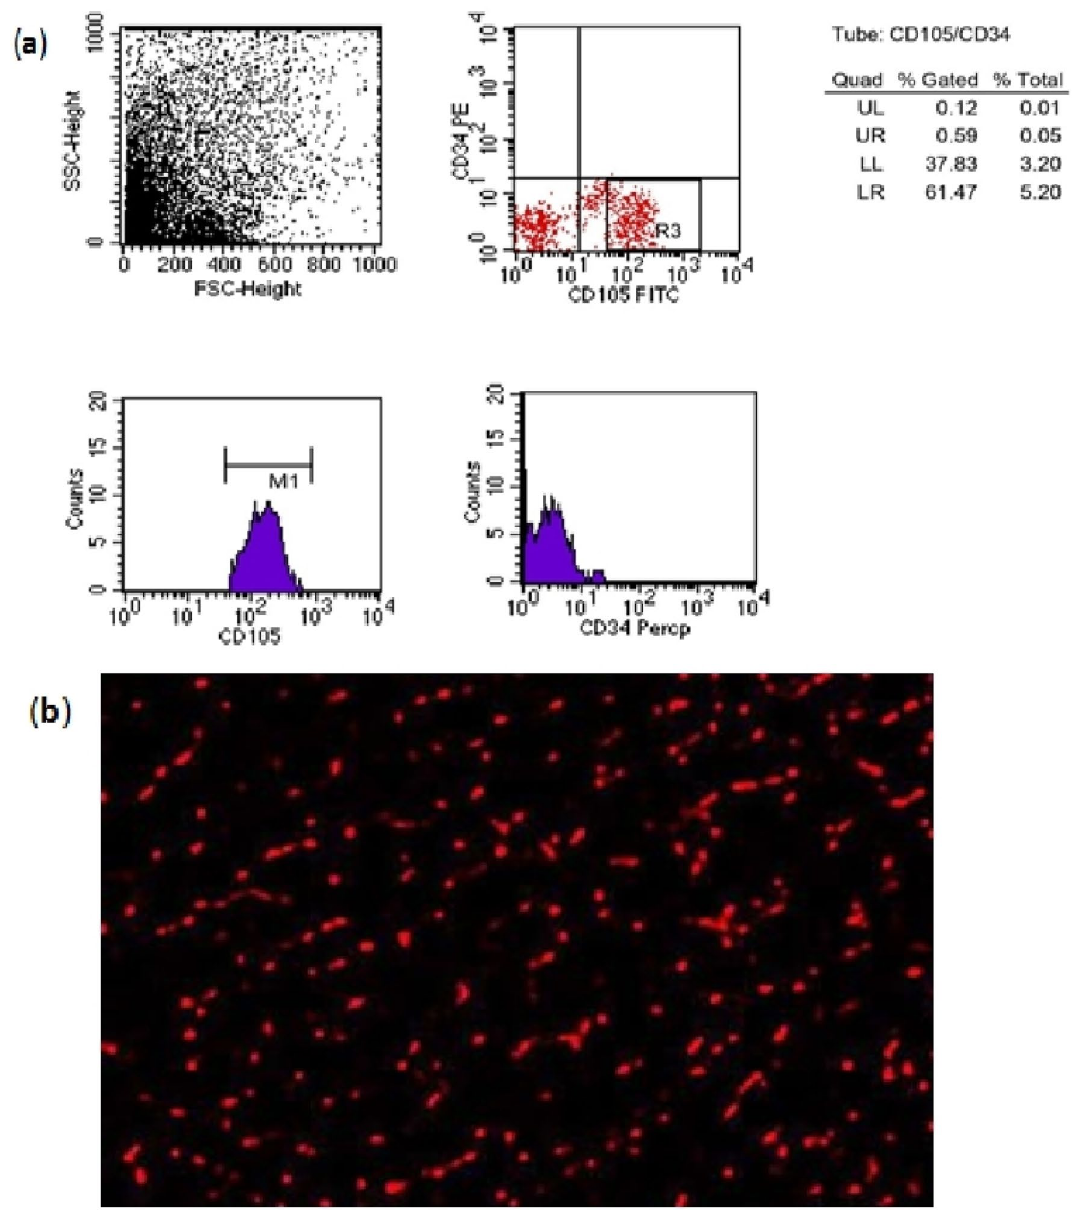
Figure 1. ( a ) Flow cytometry chart showing positive MSCs for CD105 and negative MSCs for CD34. ( b ) Representative fluorescence micrograph of cardiac tissue from cisplatin and breast milk MSc (Br-MSCs) treated group following MSc dosing displaying the homing of MSc by PKH26